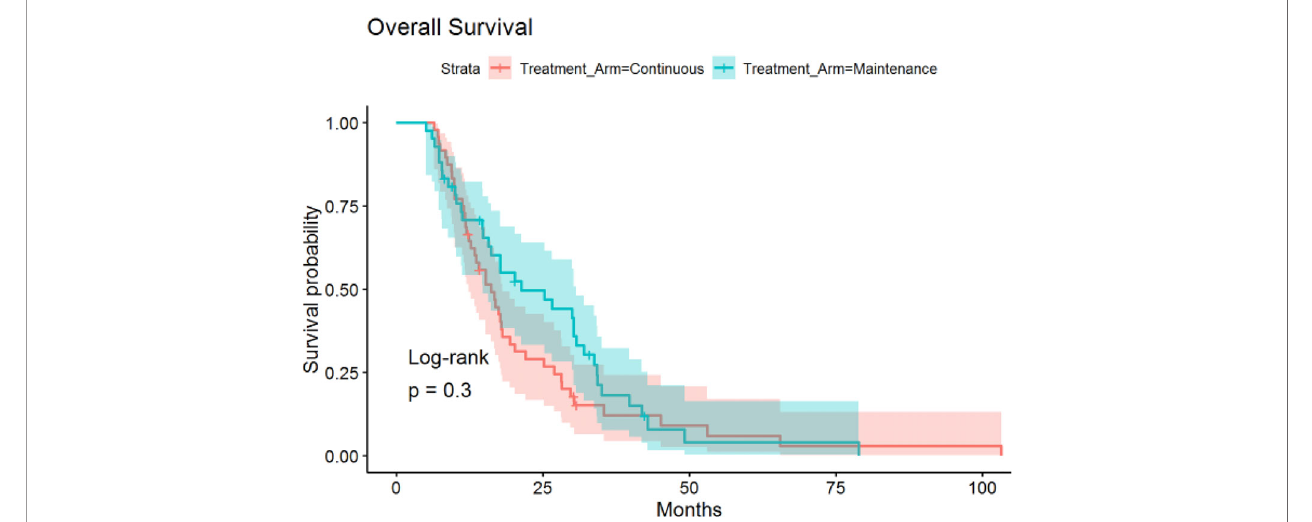
FIGURE 1 | Overall Survival in Continuous vs Maintenance Groups.